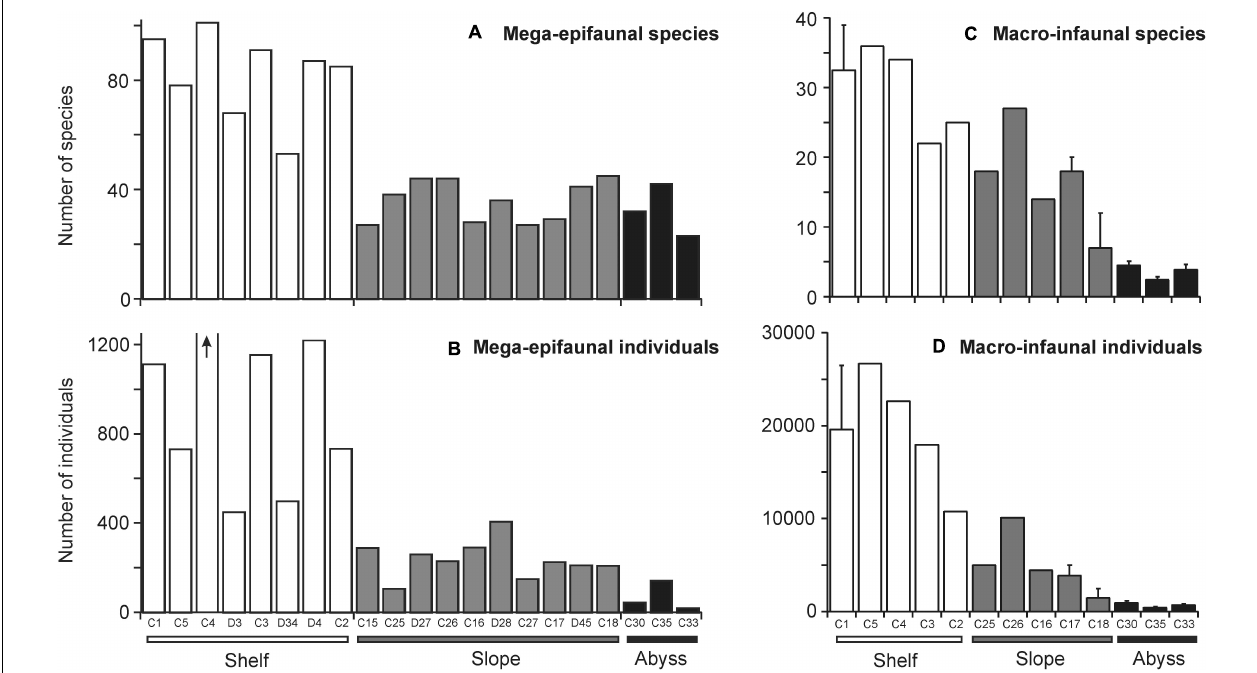
FIGURE 3 | Total number of (A) mega-epifaunal and (C) macro-infaunal species and (B,D) individuals found at each site. Sites are arranged in order of increasing depth (left to right) within the “Shelf,” “Slope,” and “Abyss” categories. The arrow on (B) indicates number of individuals at Site C4 was off the scale (2959 individuals). Standard error bars on some macro-infaunal sites indicate where multiple stations were sampled at that Core site. Note the different y-axes scales on comparable plots.